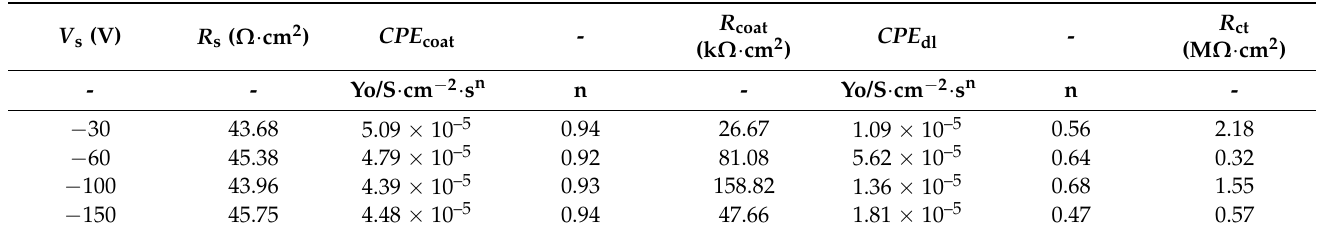
Table 3. EIS fitting parameters of the